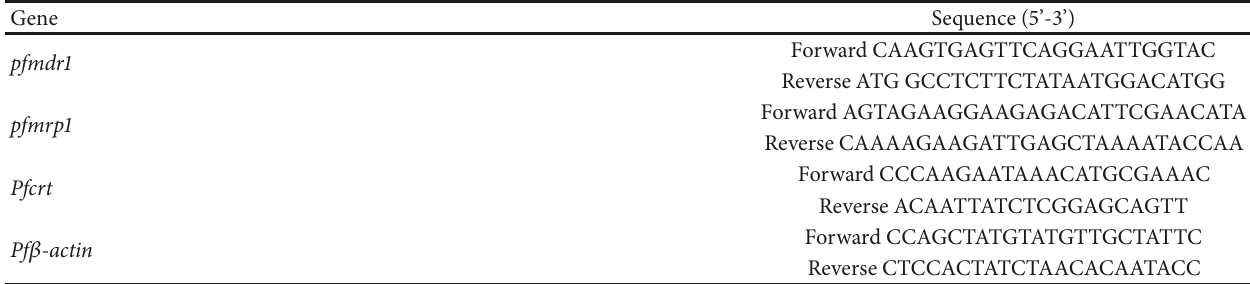
Table 1: The forward and reverse primers used for quantification of pfmdr, pfmrp1, and pfcrt gene expression.